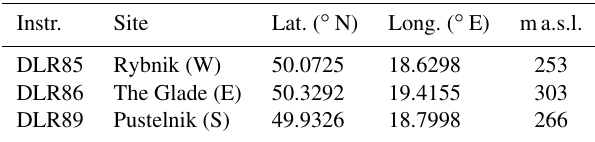
Table 1. Locations of wind lidars deployed during CoMet. The sec- ond column lists the site names with their respective cardinal direc- tions relative to the USCB in brackets.